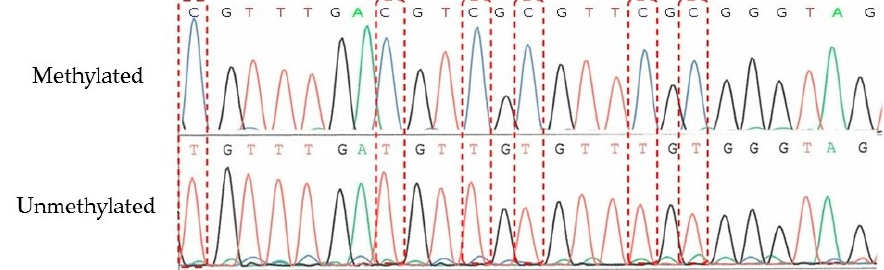
Figure 2. DNA sequencing of the MLH1 promoter region after a bisulfite reaction in the case with